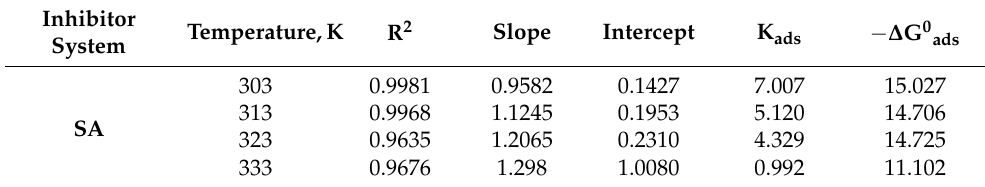
Table 5. Adsorption parameters obtained from Langmuir adsorption isotherm for the corrosion inhibitive effect of aqueous leaf extracts of SA on the corrosion of mild steel in 1.0 M